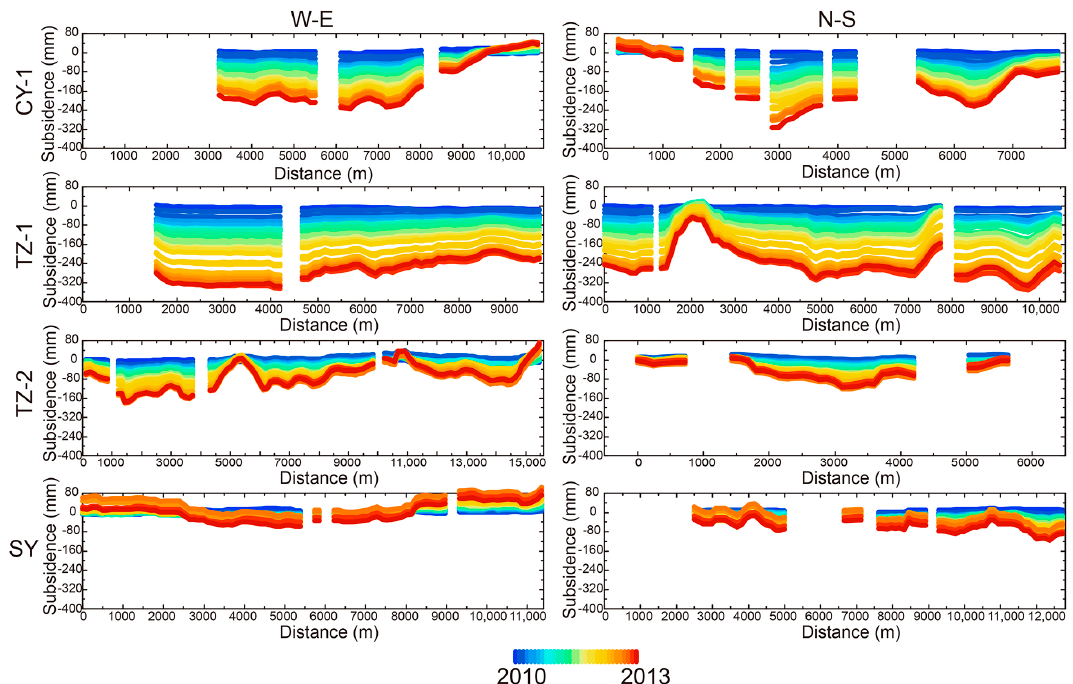
Figure 4. Profiles of InSAR vertical displacement time series (April 2010–November 2013) marked by red dashed line in Figure 2b. The gaps occur where noise is statistically significant throughout the interferograms, as described in Section 3.1.